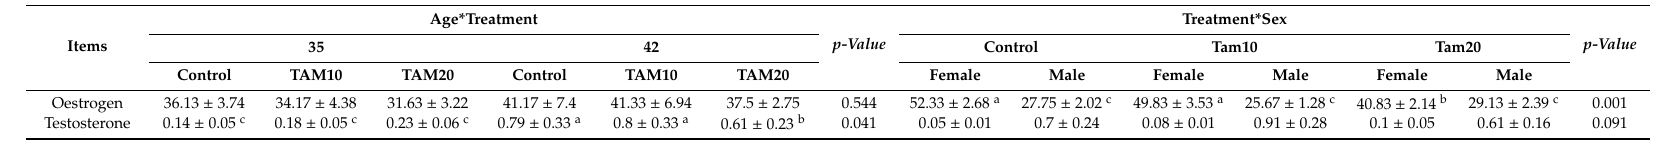
Table 7. E ff ects of interaction between age and TAM treatment and between sex and TAM treatment on serological levels of oestrogen (pg / mL) and testosterone (ng / mL) in broiler chickens (Means ± SE).